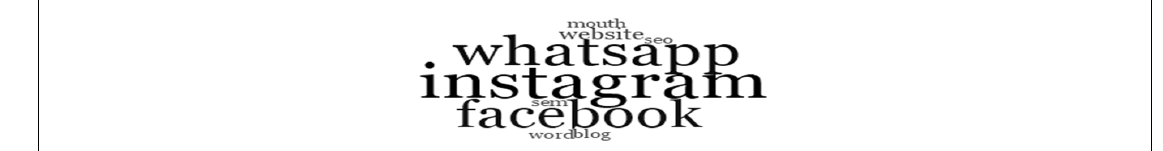
Fig. 3. Visualization of Online Marketing Tools on OBR S-commerce Source: NVivo 12 plus